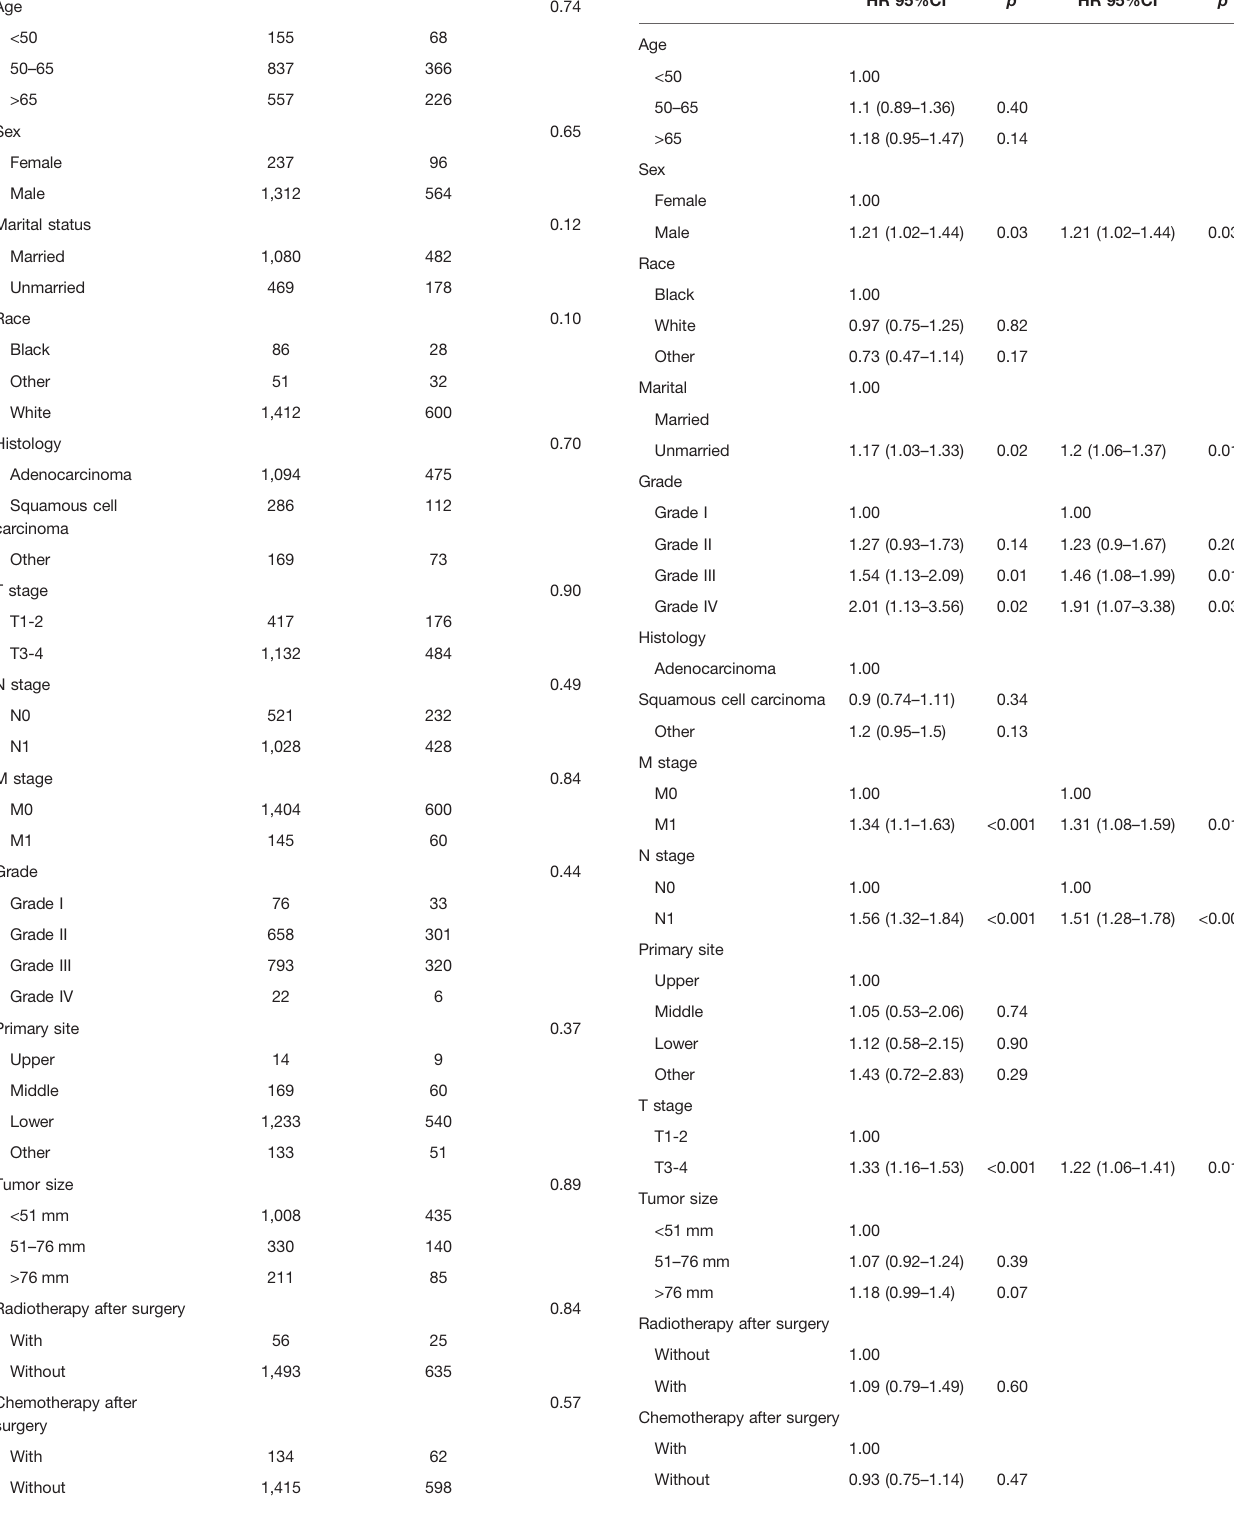
TABLE 1 | Comparisons of demographic and clinicopathological characteristics in the training cohort and validation cohort. Variables